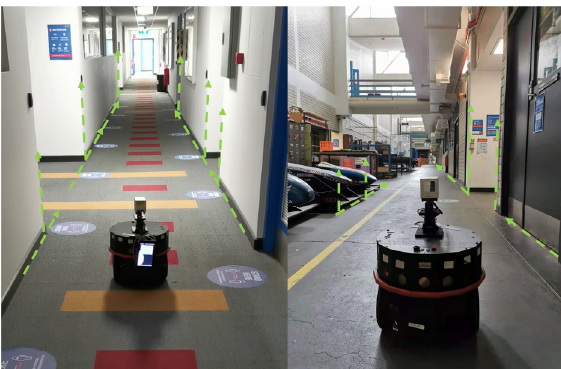
Figure 2. Corridors in the engineering department at Monash University with the wall and corner features vertically